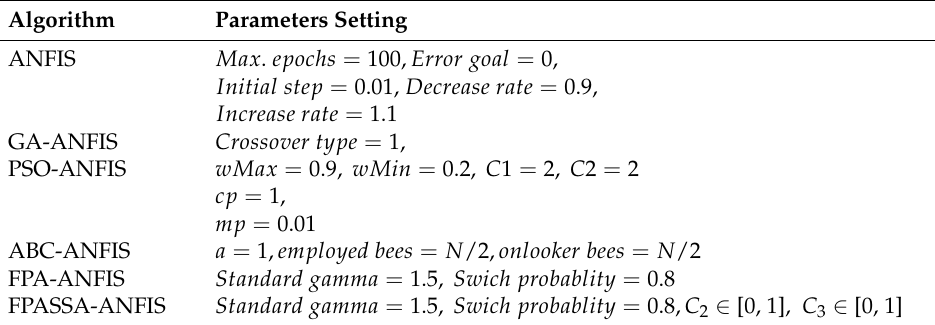
Table 2. Parameters’ setting.